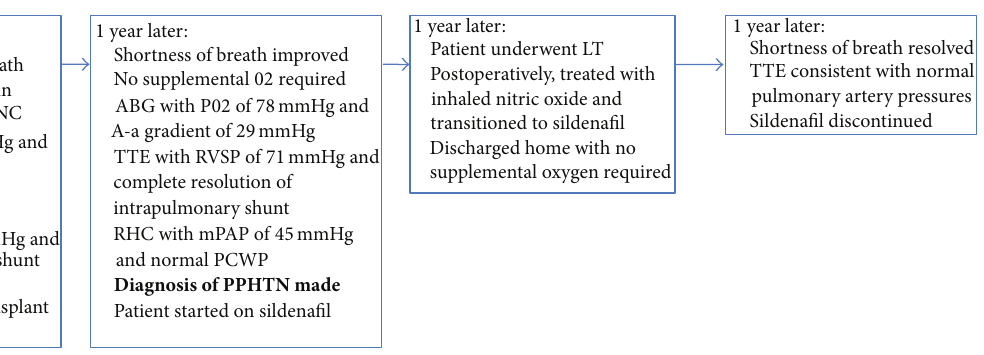
Figure 1: Sequence of events for Case 1.